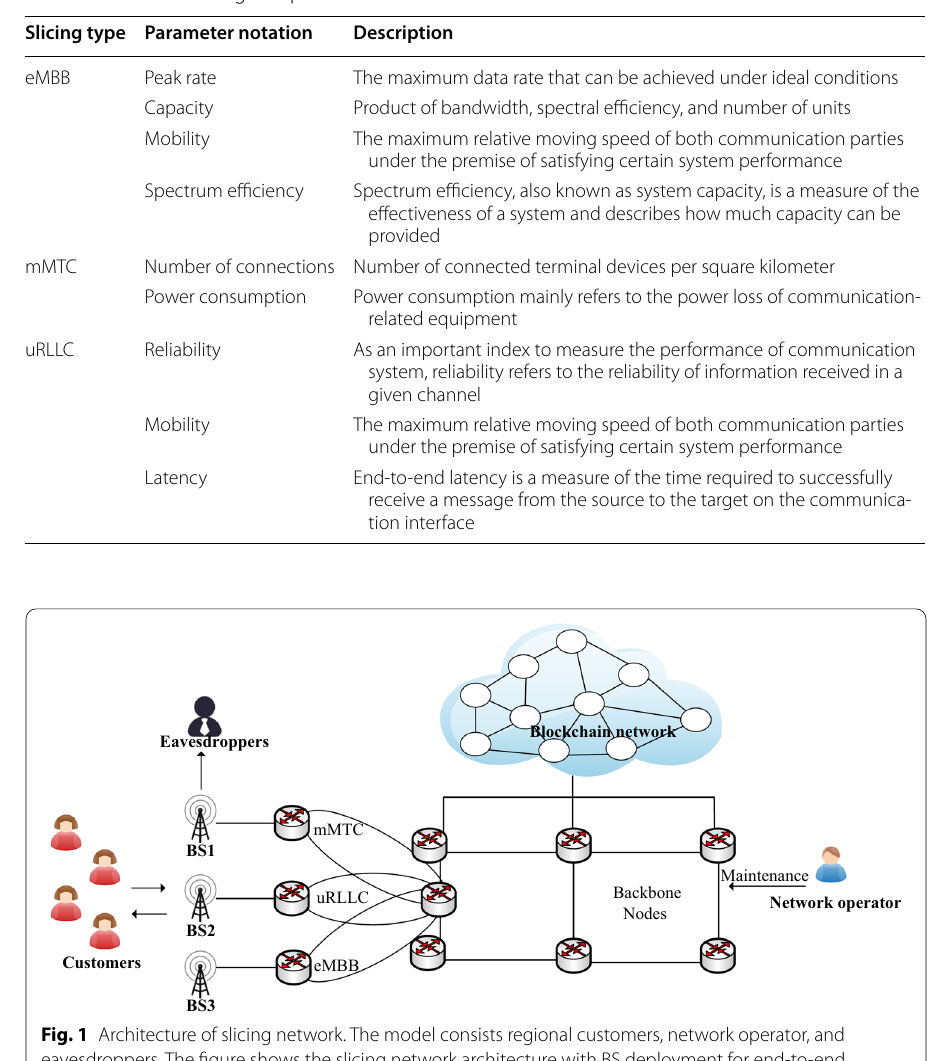
Fig. 1 Architecture of slicing network. The model consists regional customers, network operator, and eavesdroppers. The figure shows the slicing network architecture with BS deployment for